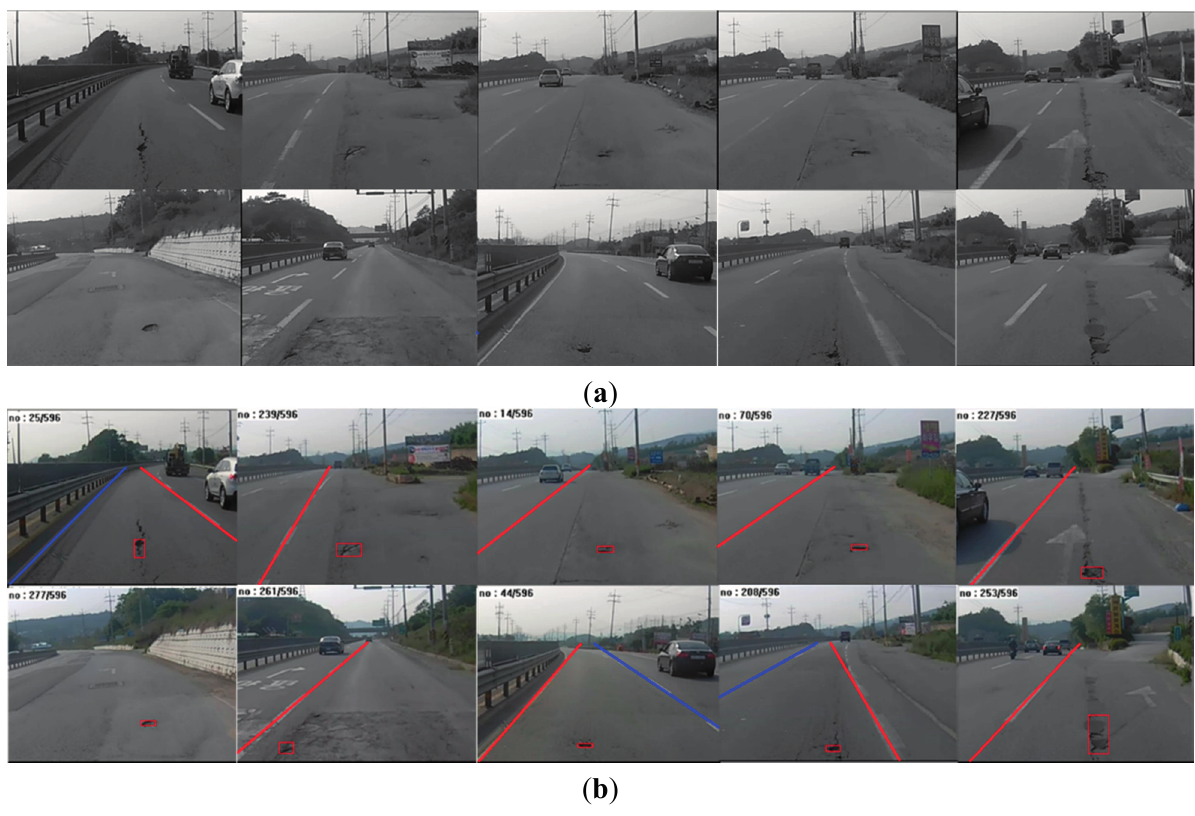
Figure 13. Examples of pothole detection: ( a ) input images; ( b ) results of pothole